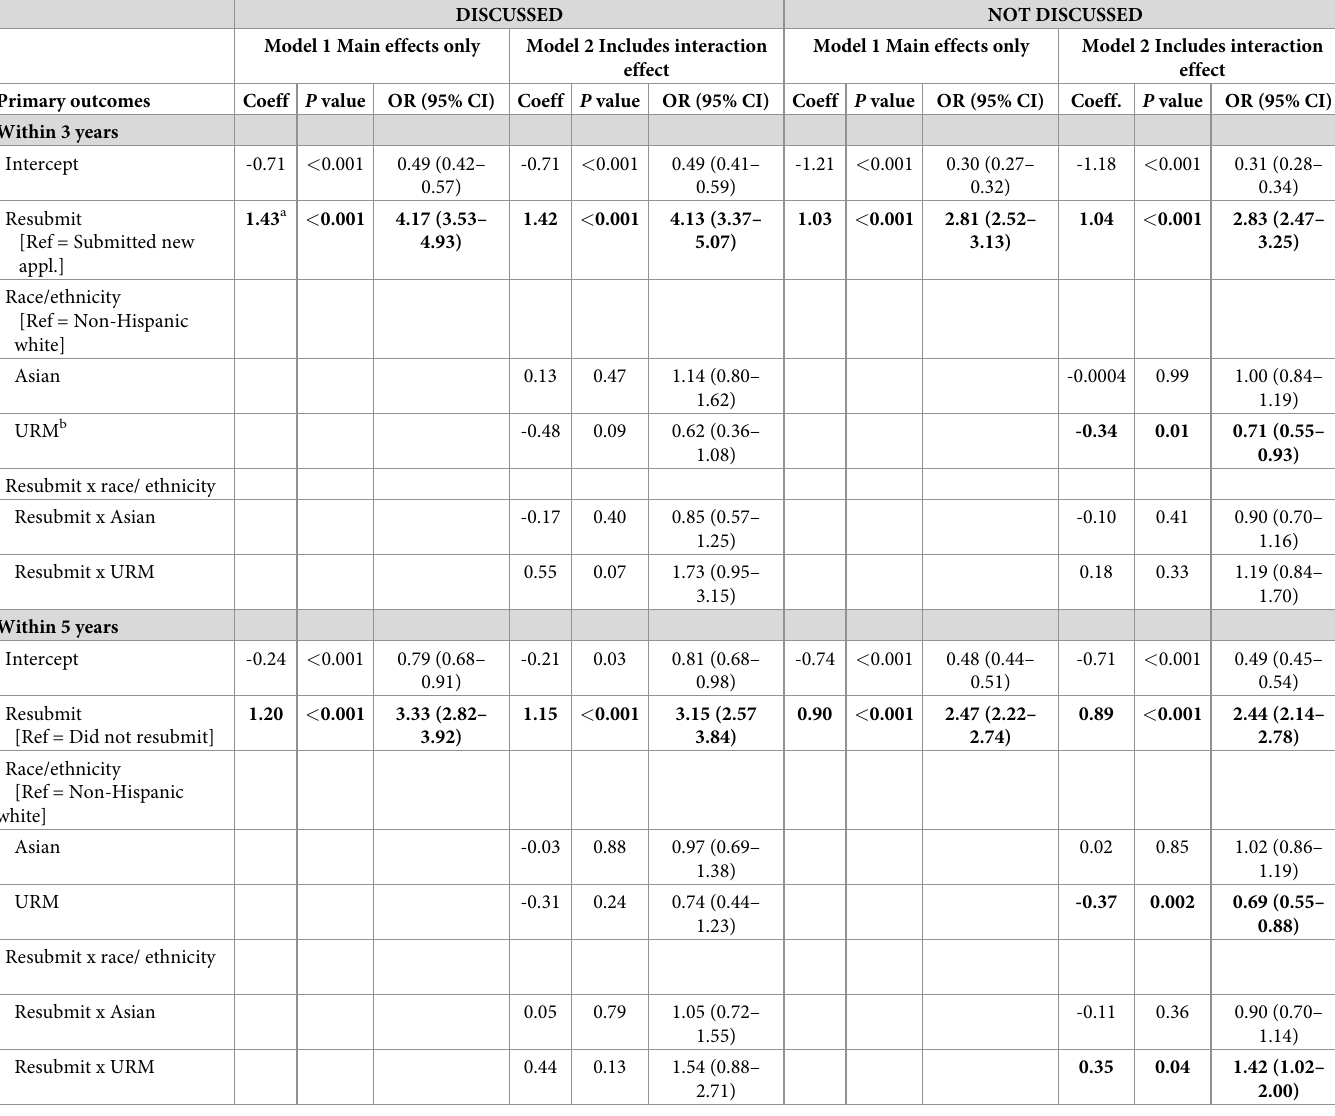
a Boldface indicates statistical significance and reference categories are indicated in brackets ([]) b Abbreviations: URM, Underrepresented